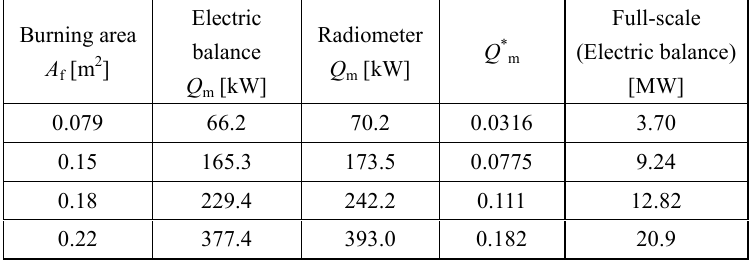
Table 2 Average heat release rate Q m of each burning area A f of the combustion vessel Electric Burning area Radiometer balance A f [m 2 ] Q m [kW] Q m [kW]